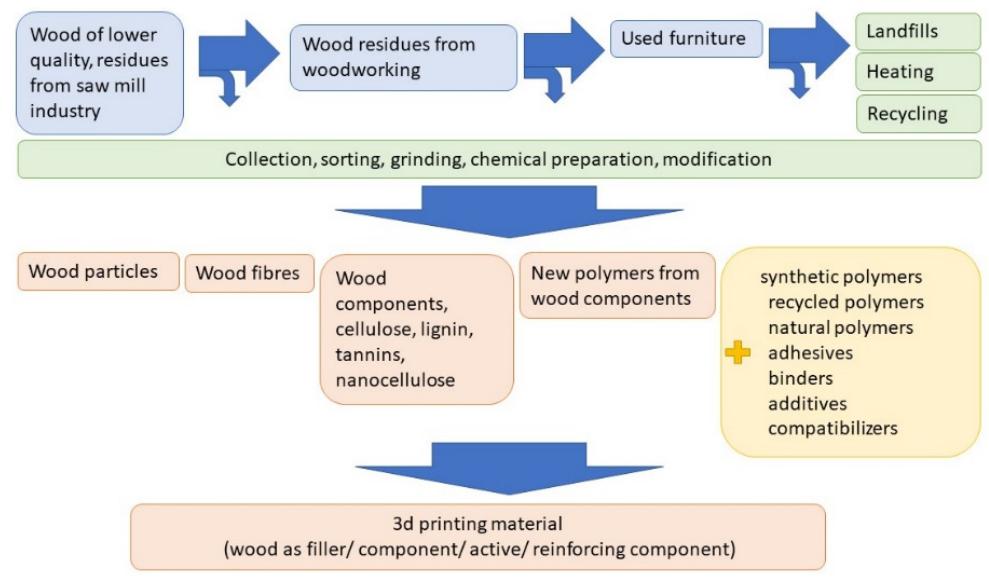
Figure 3. Possible sources for wooden material for use in additive manufacturing.